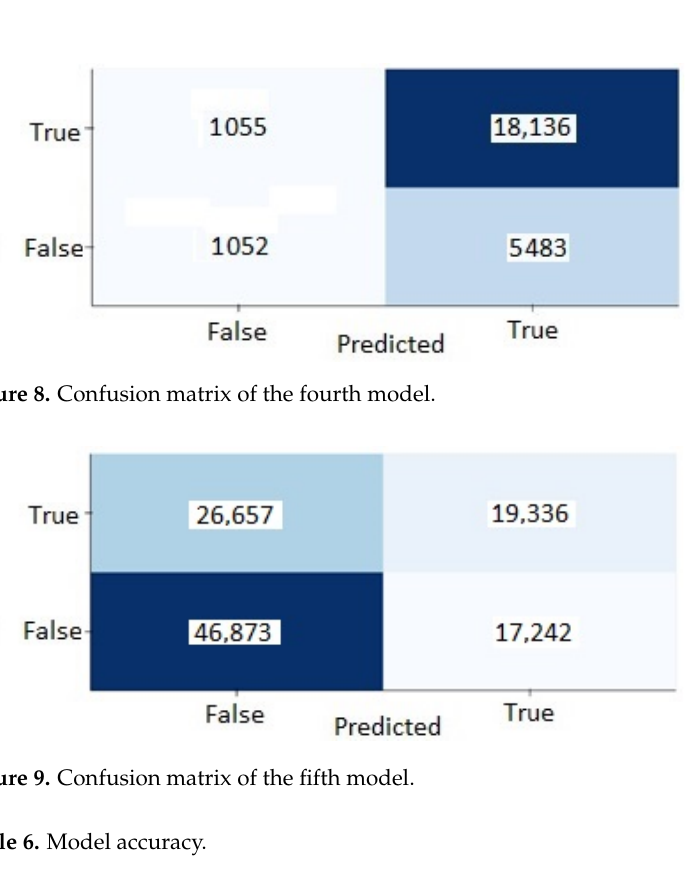
Figure 7. Confusion matrix of the third model.